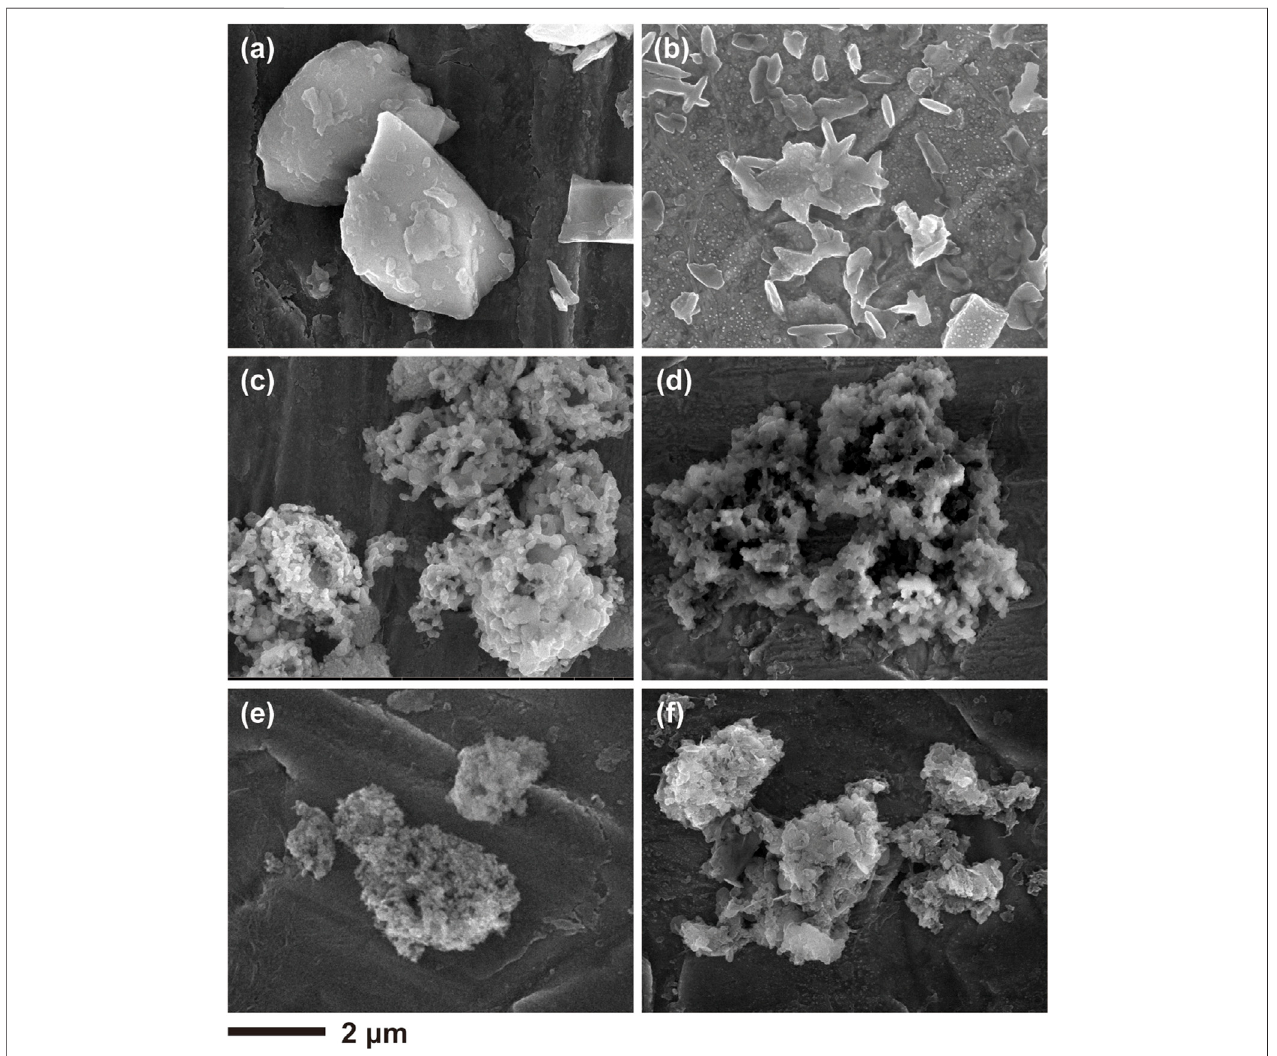
FIGURE 4 | SEM images of (A,B) bulk silicon (C,D) macroporous silicon and (E,F) macroporous Si@C composites before and after 100 cycles.